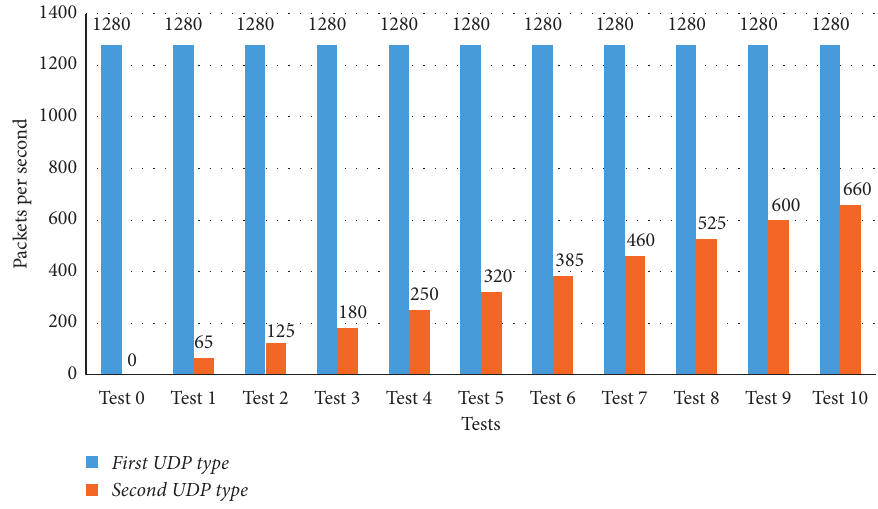
Figure 3: Generated traffic